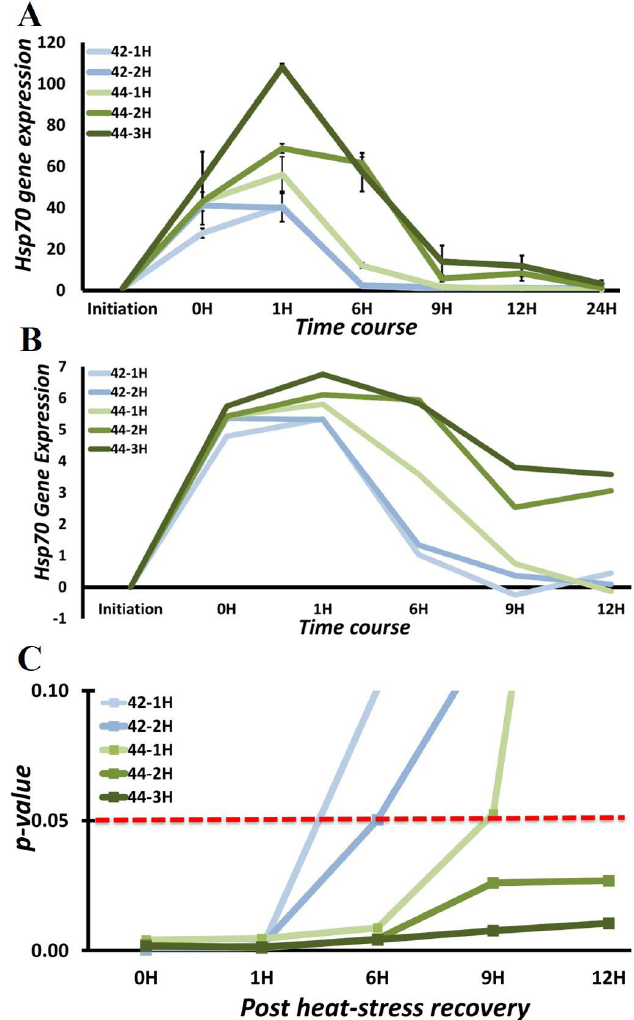
Figure 4. Dose-responsive nature of heat stress in DBMSCs ( A ) Time-course analysis of Hsp70 gene expression induction at 42 °C for 1 and 2 h and at 44 °C for 1, 2, and 3 h. ( B ) Log 2 Fold Change plot for Hsp70 induction. Temperature elicits larger response as can be judged from difference between 44-2H and 44-1H. As the magnitude of heat stress increases, the heat shock response increases